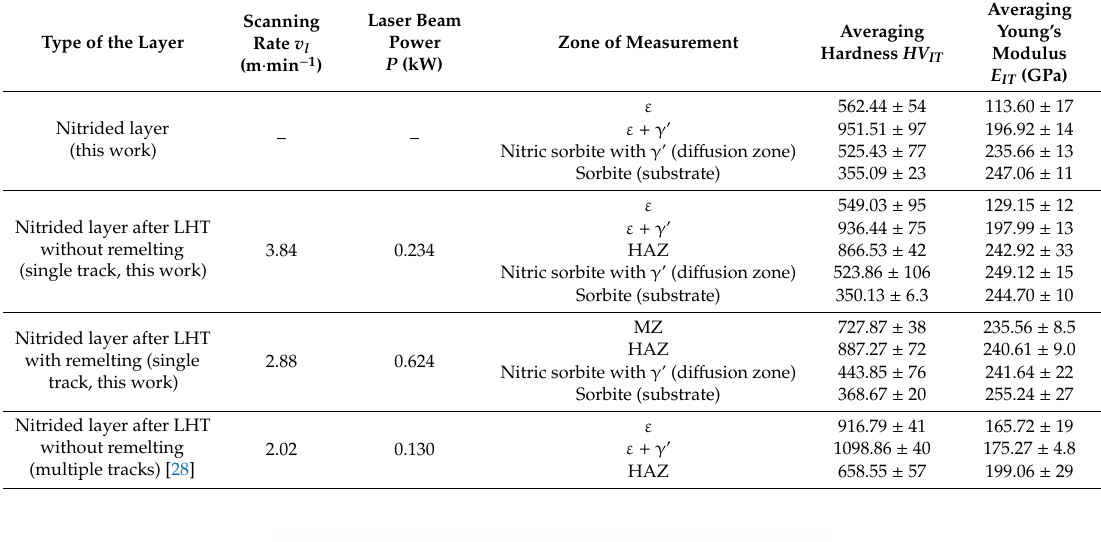
Table4. Averaging HV IT and E IT valuesinnitridedlayer, nitridedlayerafterLHTwithoutremelting, and nitrided layer after LHT with remelting and their standard deviations compared to the previous results.